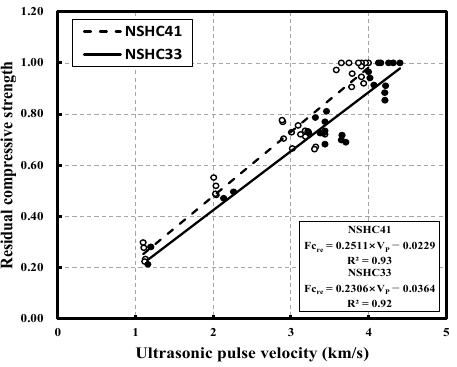
Figure 12. Correlation between residual compressive strength and ultrasonic pulse velocity in NSHC after high ‐ temperature exposure.